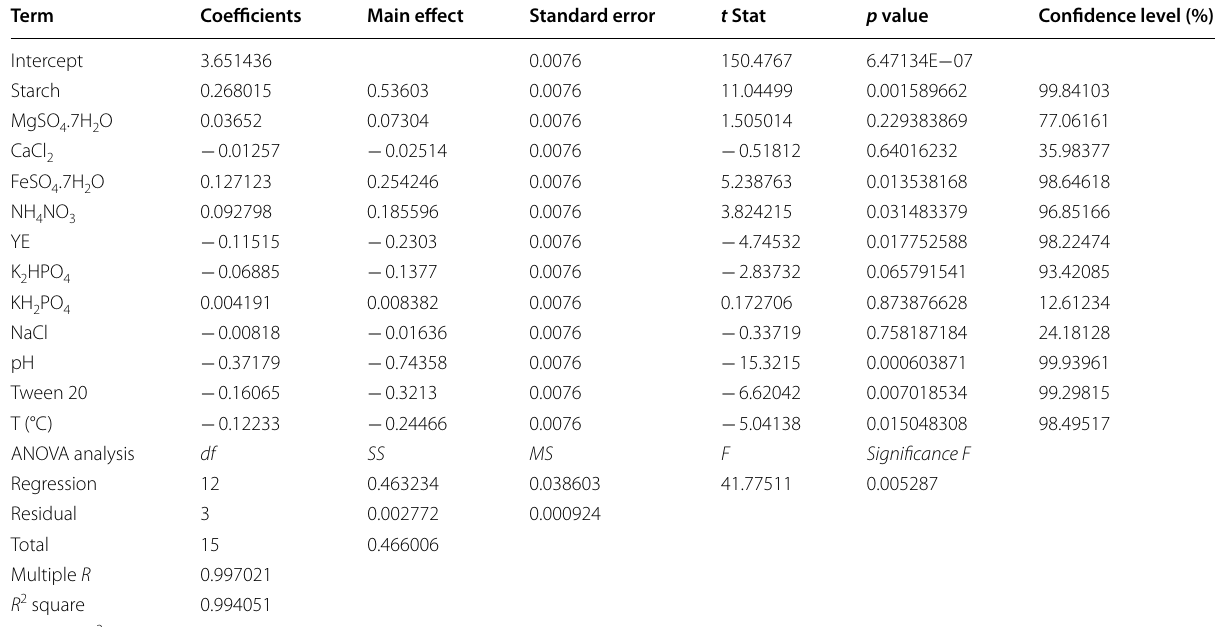
Table 2 Statistical analysis of PB showing coefficients and t and p values for variables affecting the CHO production by Streptomyces sp.